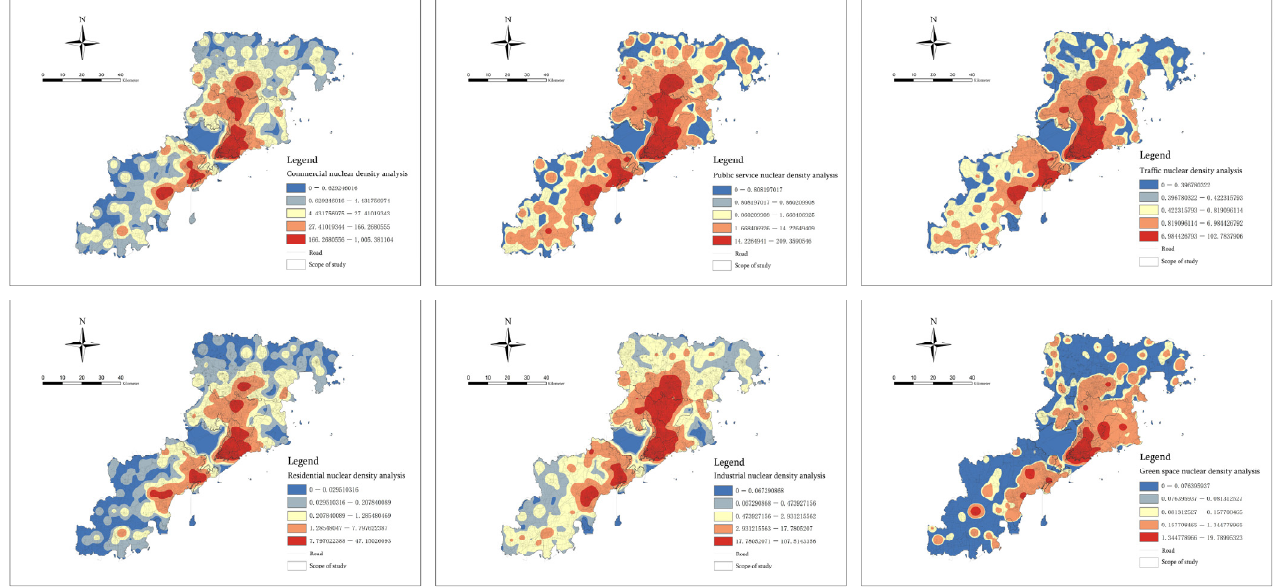
Figure 9. Kernel density estimation analysis of POI data representing six functional categories.